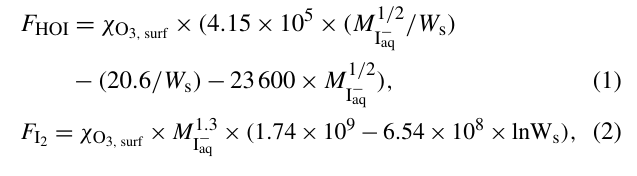
Table 1. Iodine source gases (ISGs) incorporated in SOCOL-